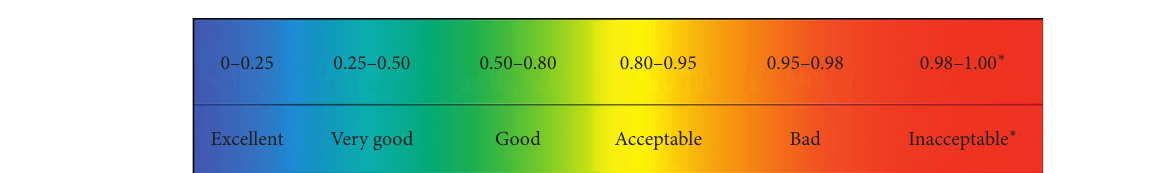
Table 1: Skewness mesh quality grades [21].